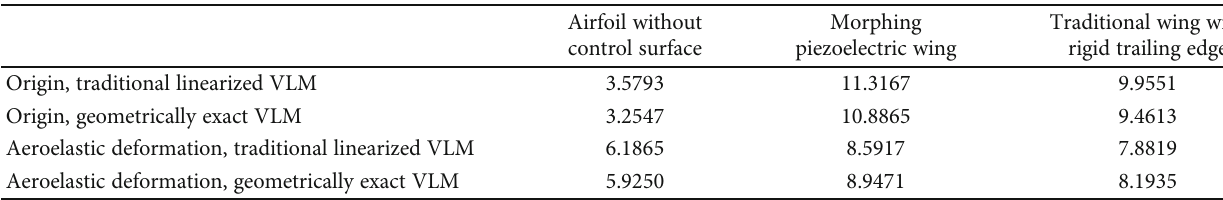
Table 3: Total aerodynamic